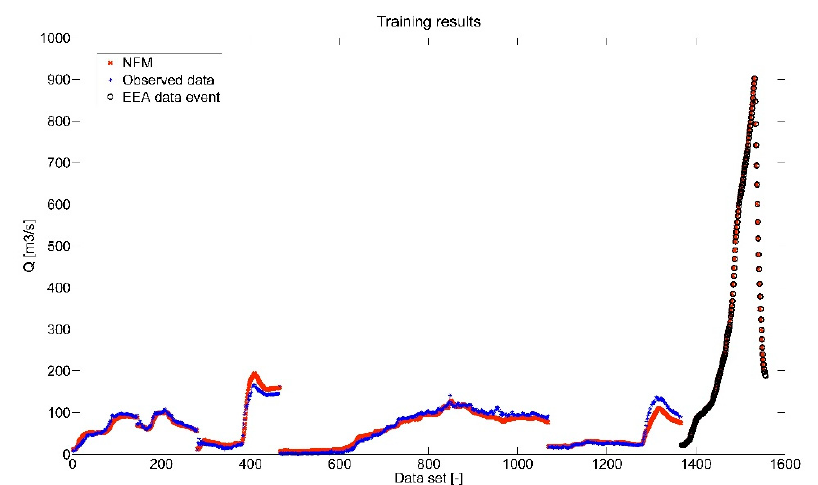
Figure 8. Calibration results for the selected episode in the Bechynˇe profile. Figure 8 plots the training data (blue) and the result of the trained post-processing model (red). An artificial training episode provided by the EEA algorithm is also shown (black circles).